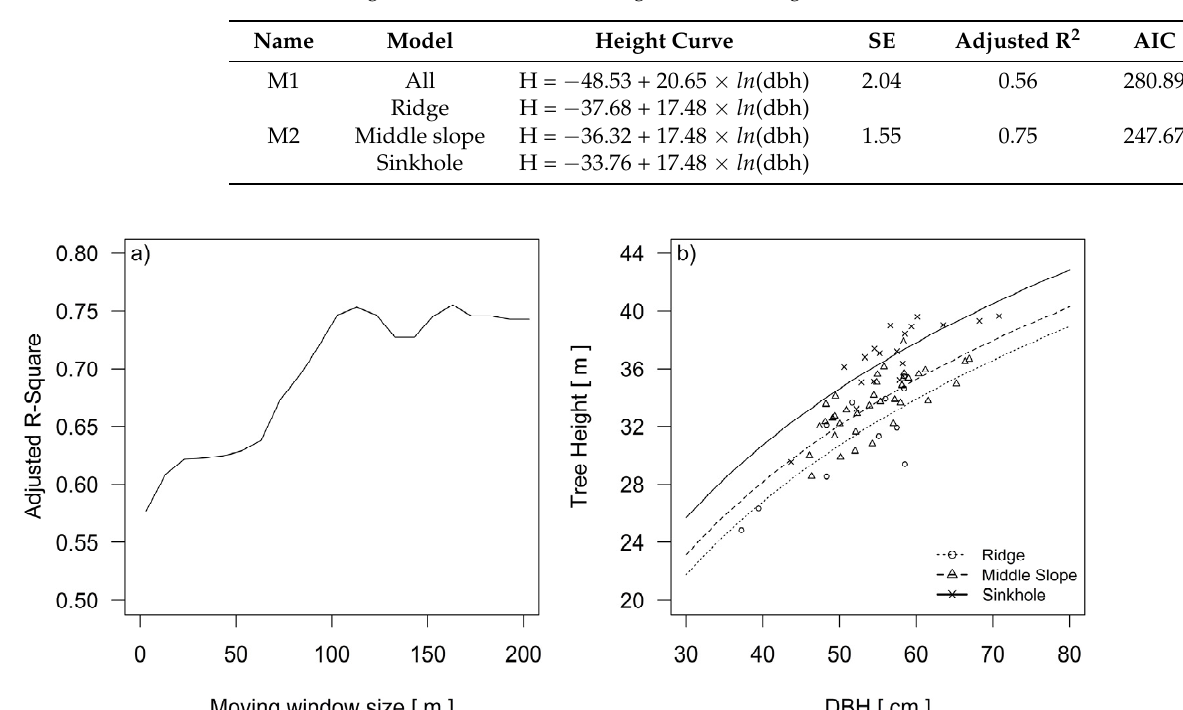
Table 1. Results of the regressions between silver fir tree height and silver fir dbh without considering landform categories (M1) and considering landform categories (M2).